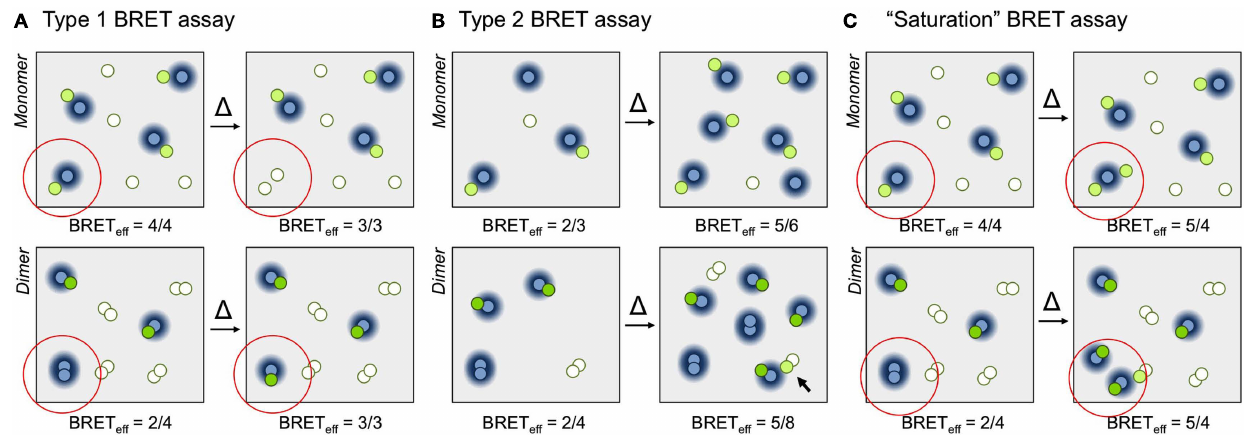
Figure 1 | Principles of BreT assays. (A) In a type 1 BRET assay the acceptor/donor ratio is increased but surface density is kept constant. The increase in acceptor/donor ratio is obtained by exchanging a donor for an acceptor (the change is indicated within the red circle). For simplicity, BRET defined here as the ratio of the numbers of fluorescent acceptors and luminescent donors. In the examples shown, for the monomer (top) BRET unchanged (3/3 versus 4/4), whereas for the dimer (bottom) the ratio increases from 2/4 to 3/3 as the fraction of productive dimers increases. (B) In a type 2 BRET experiment, the acceptor/donor ratio is kept constant and surface density is varied, in this case by a factor of two. Due to the increase in monomer density (top) the likelihood of random collisions increases, and BRET increases from 2/3 to 5/6. For constitutive dimers (bottom), however, eff BRET is largely unchanged , increasing from 2/4 to 5/8, because the likelihood eff of dimerization doesn’t change. Only random interactions of dimers (arrow)